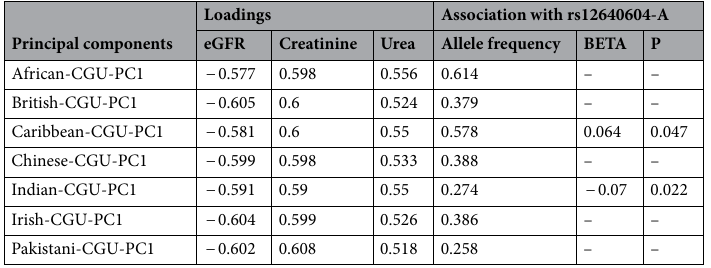
Table 3. Association analyses of rs12640604-A and in UKBB data and CGU-PC1 in each UKBB subgroup. (–) Association results with P-values > 0.05.